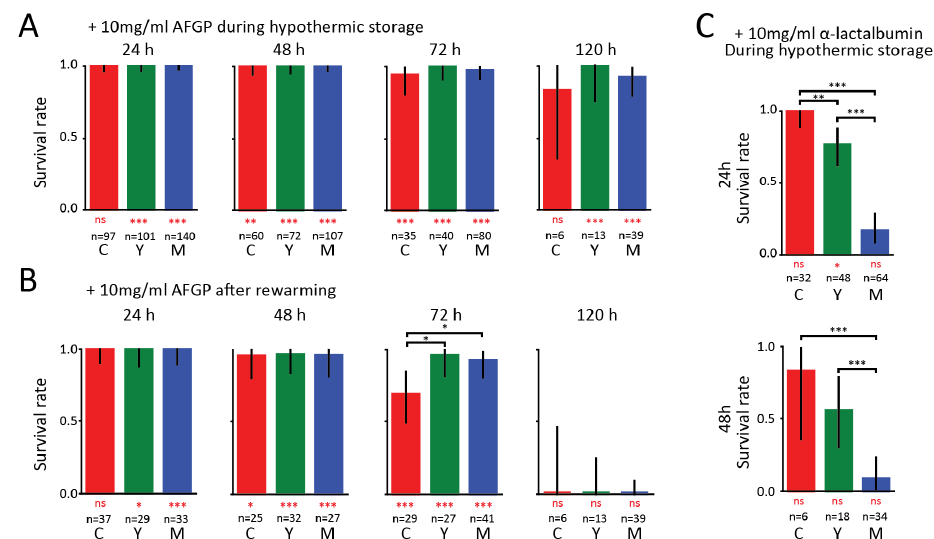
Figure 2. Survival of organoids under hypothermic conditions with antifreeze glycoprotein (AFGP) and α -lactalbumin present. ( a ) Survival rates of organoids at the different developmental stages when AFGP was added to the growth medium. Rates were obtained from visually assessing the organoids every 24 h during hypothermic storage periods ranging from 24 to 120 h. Bars show results pooled from different independent experiments. ( b ) Corresponding survival rates obtained from a visual assessment performed two to three days after the organoids were returned to the incubator. ( c ) Survival rates of organoids at the different developmental stages when α -lactalbumin was added to the growth medium. Black asterisks denote significant differences between developmental stages, and red asterisks below bars denote differences from controls in Figure 1 (* p < 0.05, ** p < 0.01, *** p < 0.001, ns: not significant).